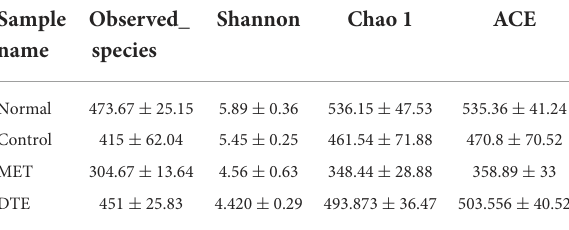
TABLE 3 Effect of DTE on intestinal microbial diversity db/db diabetic